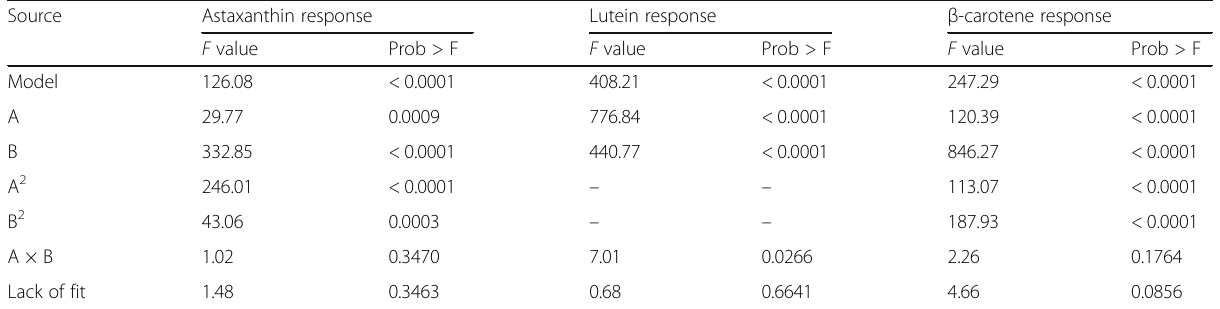
Table 2 ANOVA results for the responses model Source